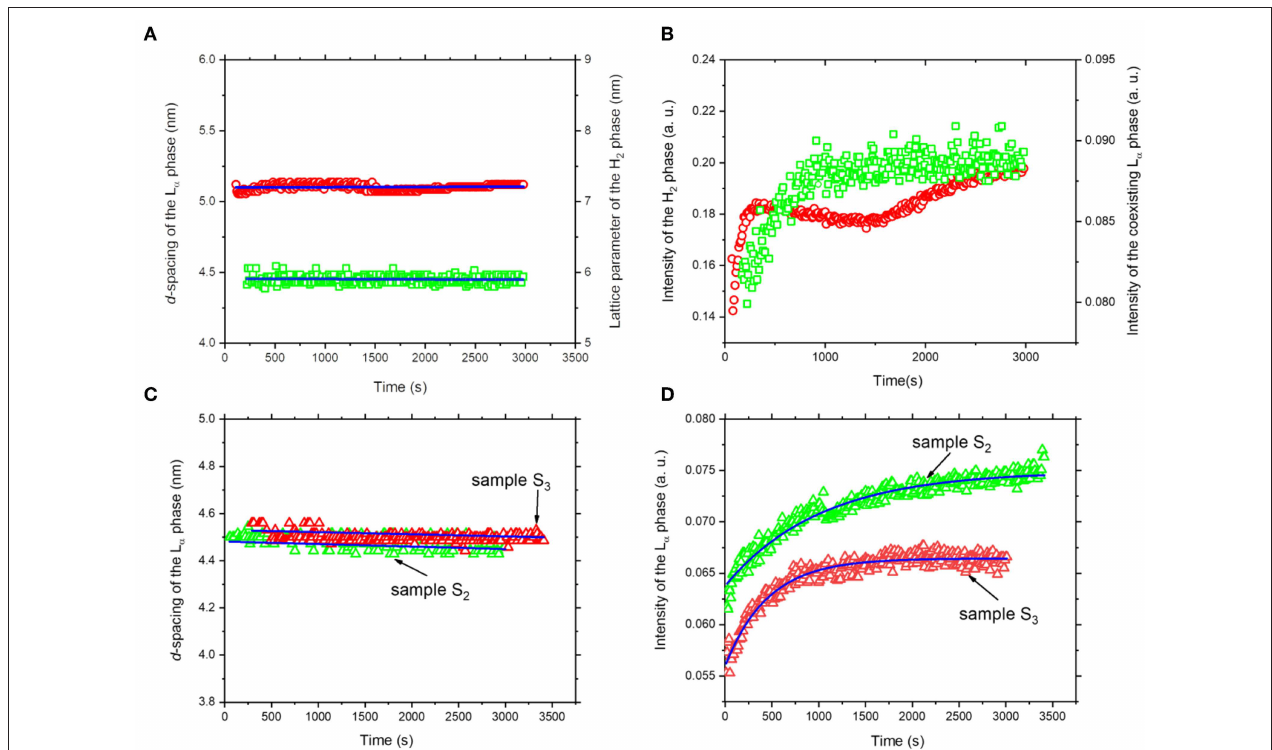
FIGURE 5 | The calculated lattice constants (A) and temporal evolution (B) of the detected inverse hexagonal (H 2 ) and lamellar (L α ) phases during lipolysis of sample S 1 (sodium caseinate-stabilized KO emulsion). The H 2 and L α phases are represented by open red circles and green squares, respectively. For samples S 2 and S 3 , the calculated lattice constant (C) and temporal evolution (D) of the detected lamellar (L α ) phase during lipolysis are represented by open red and green triangles, respectively. In (D) , the solid blue line shows the best single exponential fit to the data. In (A,C) , the lattice constants of the liquid crystalline phases were calculated from the SAXS profiles presented in Figure 2